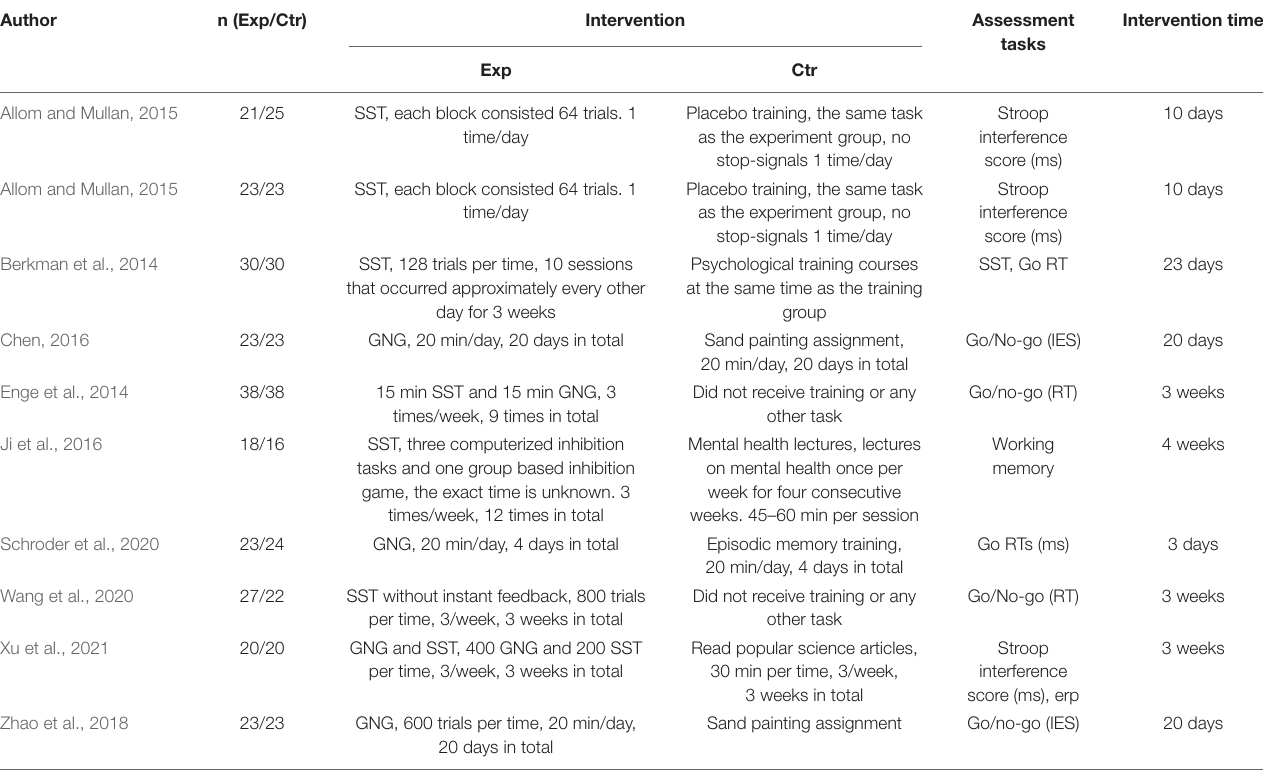
TABLE 1 | Summary of the demographic and clinical characteristics of the included RCT studies (general response inhibition training vs. control